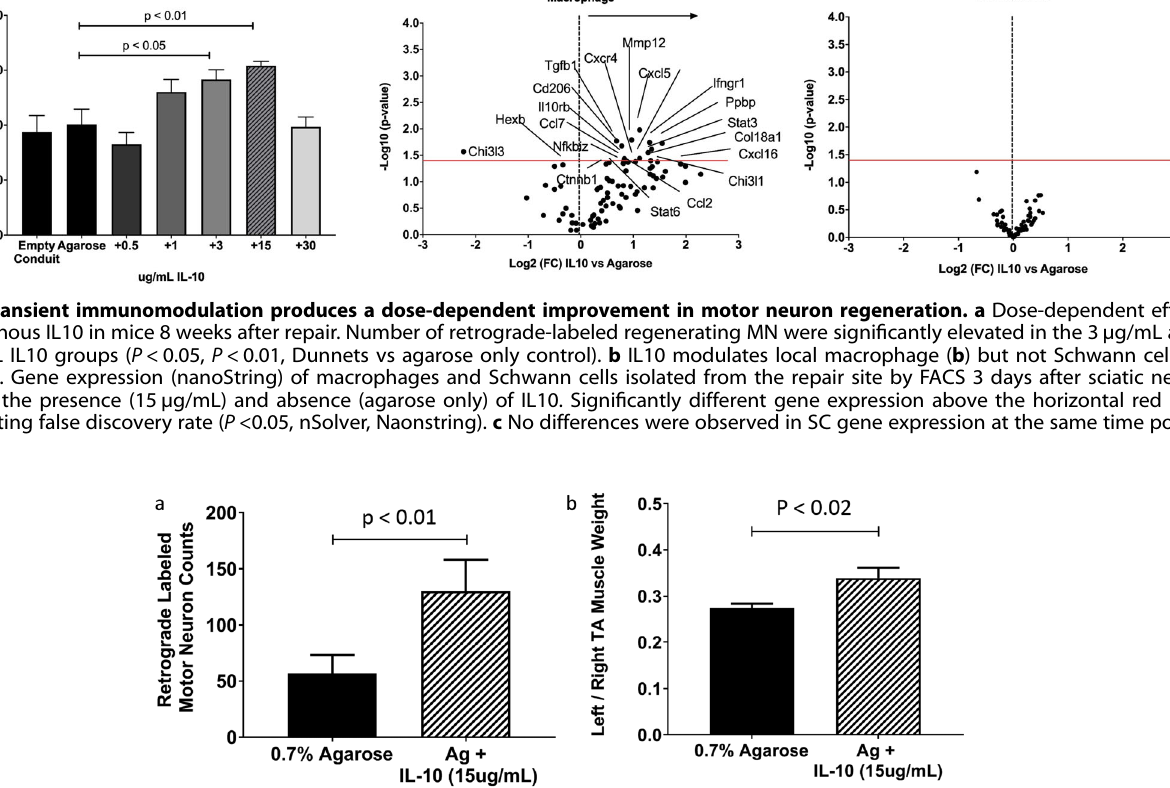
Fig. 7 Exogenous IL10 signi fi cantly improves recovery of reinnervation after delayed repair. Number of regenerated motor neurons ( a , P < 0.01) and left:right TA muscle mass ( b , P < 0.02) signi fi cantly increased with transient immunomodulation of murine sciatic nerve repair with exogenous IL10 (15 µg/mL) vs agarose only control 8 weeks after repair. The tibial (TIB) nerve branch was transected in mice. After 8 weeks of delay, the proximal (common peroneal, CP) and distal (TIB) stumps were aligned and sutured 1 mm into a 5-mm silicone nerve conduit to create a noncritical defect (3 mm) in a CP-TIB graft. Retrograde labeling was conducted 8 weeks after repair. Signi fi cance set at P < 0.05 using t